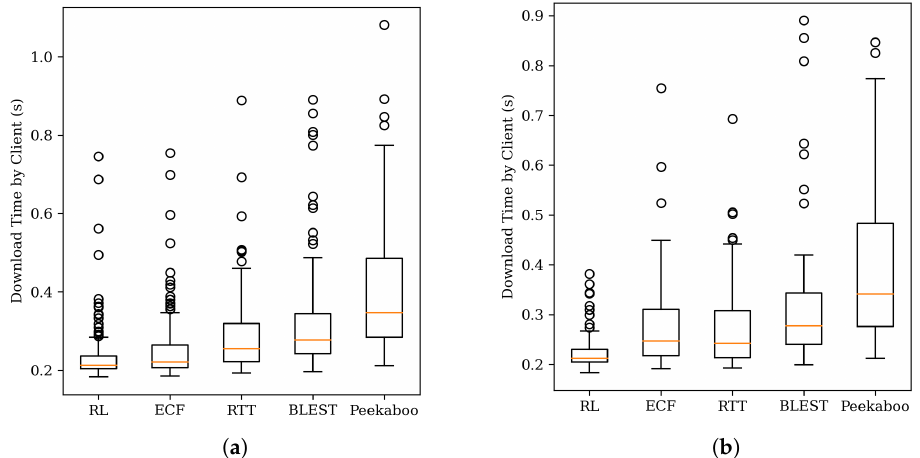
Figure 10. Chunk download times for packet loss network. ( a ) All segments. ( b ) Segment after 150 s.